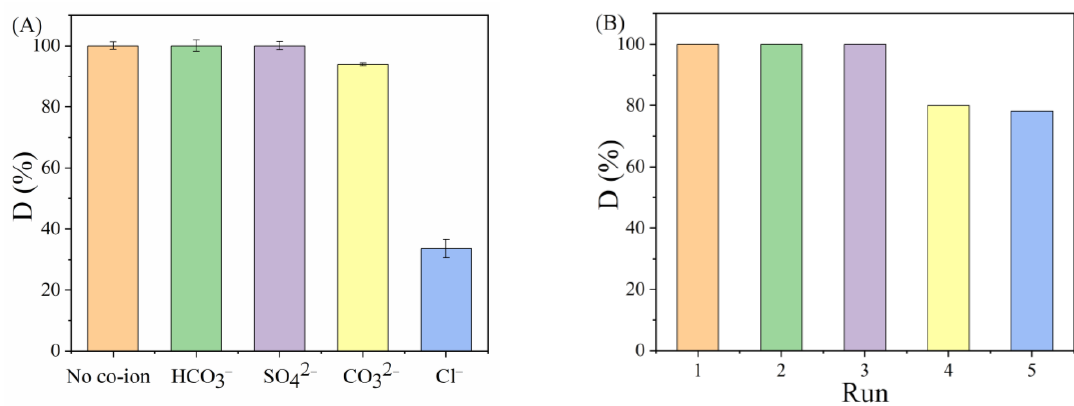
Figure 5. ( A ) The impact of coexisting ions on PPOA degradation; ( B ) renewability of PAN A F-FeOOH for PPOA degradation.